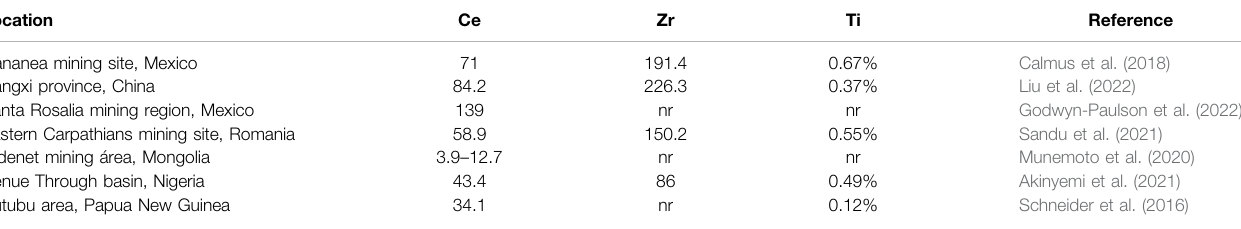
TABLE 3 | Cerium, titanium, and zirconium content reported in riverbank sediments near mining zones worldwide. Concentrations in mg.kg − 1 , unless otherwise stated. Not reported (nr). Location Ce